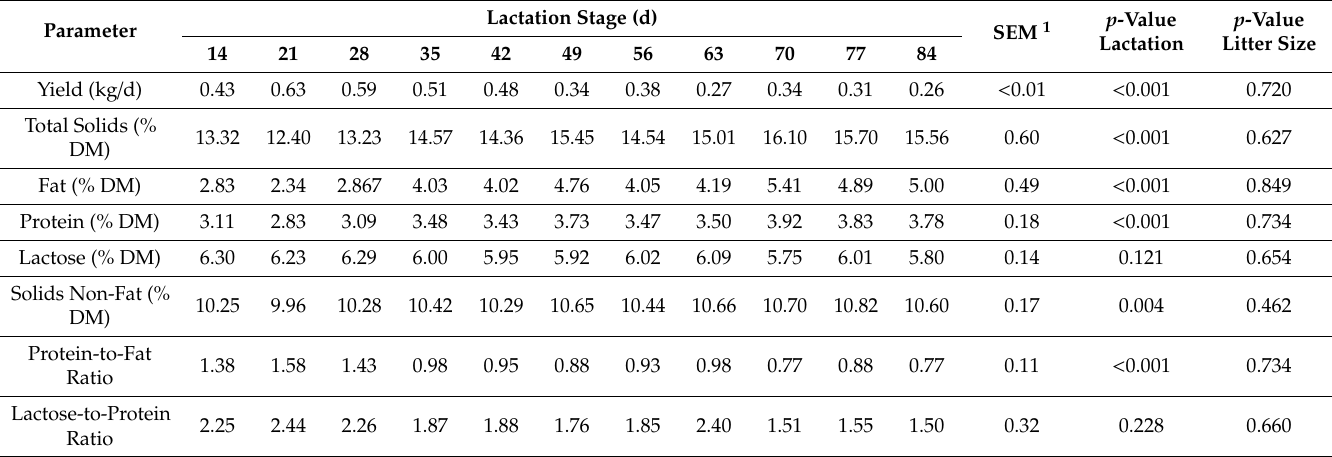
Table 1. Pelibuey ewes milk composition and yield at di ff erent lactation stages.